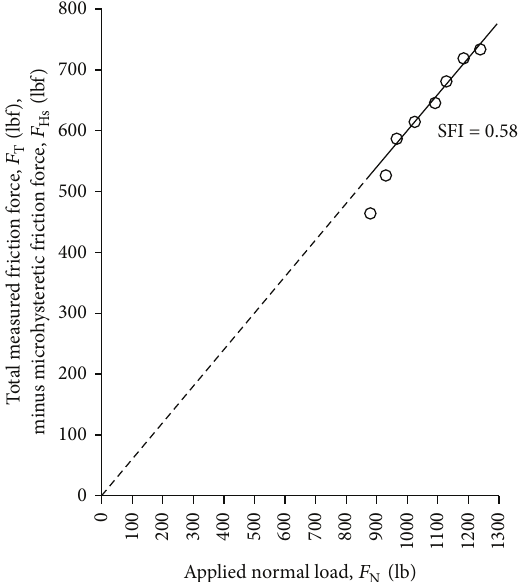
Figure 20: Dry Tyrone Boulevard test results showing the sliding friction index (SFI) value.